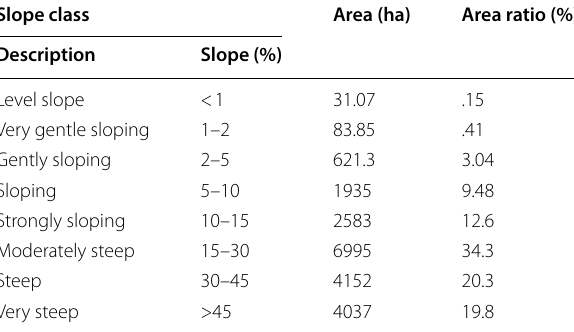
Table 4 Slope classes (modified from FAO 2006) and